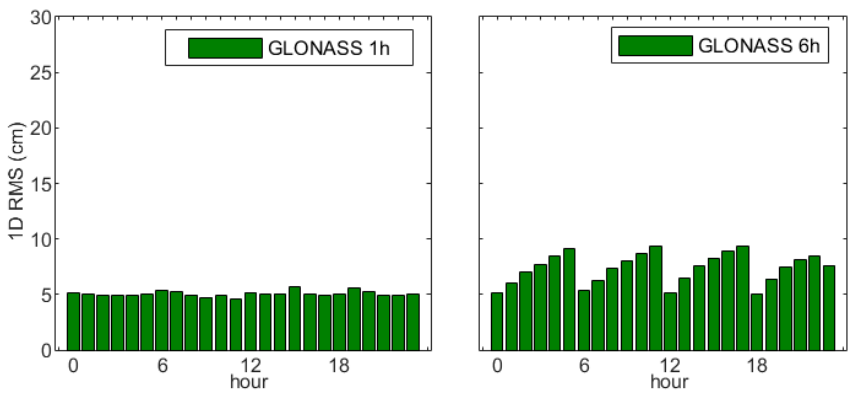
Figure 8. Accuracy of GLONASS ultra-rapid predicted orbit updated per 6 h and GLONASS ultra- rapid predicted orbit updated per 1 h.